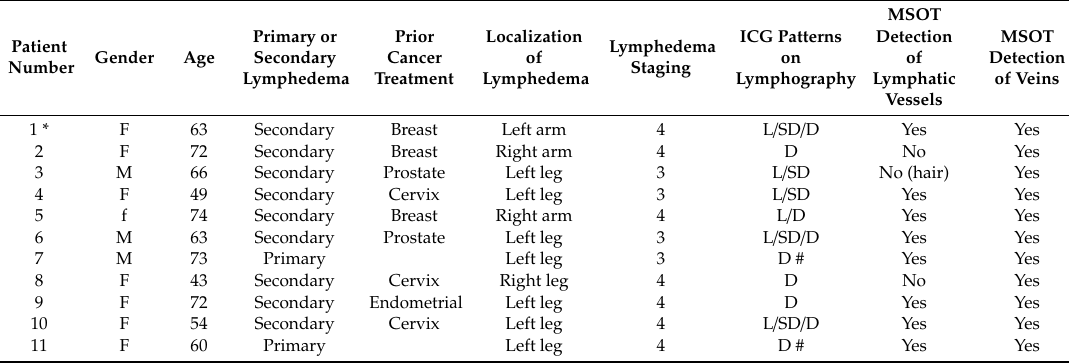
Table 1. Characteristics of the patients included in the pilot